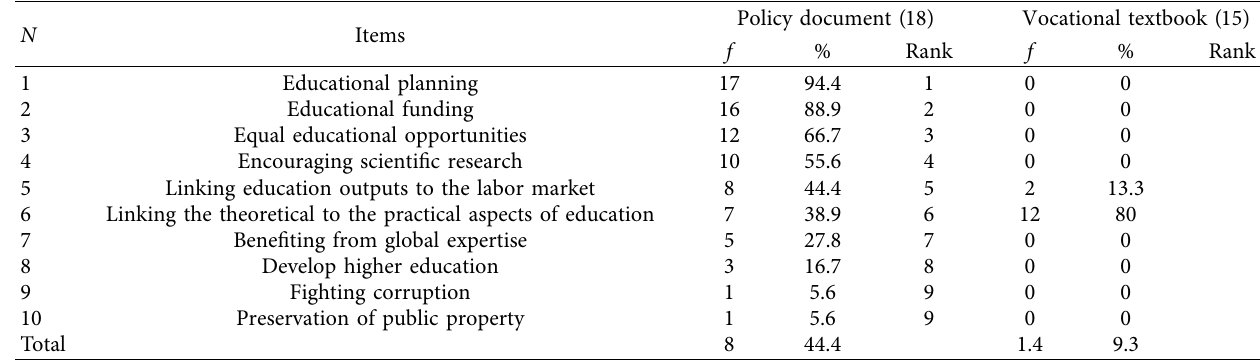
Table 6: The descending order of economic values related to economic development included in the Education Policy Document (18 chapters) and the vocational textbook in Saudi Arabia (15 lessons).